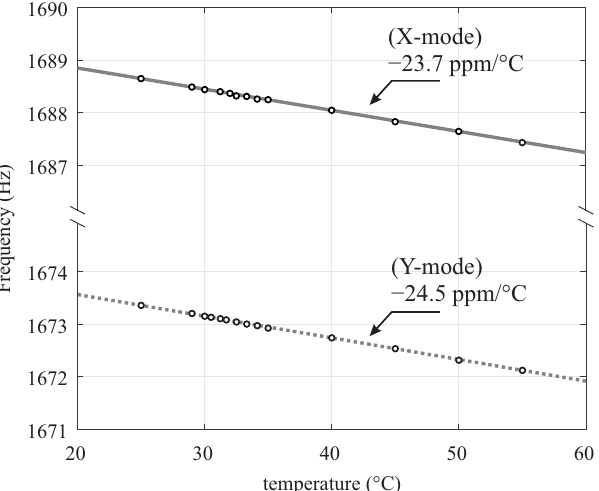
Figure 10. Experimental results of the TCF along X-axis and Y-axis of the sensor with as-fabricated ∆ f of 15Hz. The measurement was performed in a thermally-controlled environment, with temperature ranging from 25 to 55°C, and temperature fluctuations within 0.04°C at each measurement point.